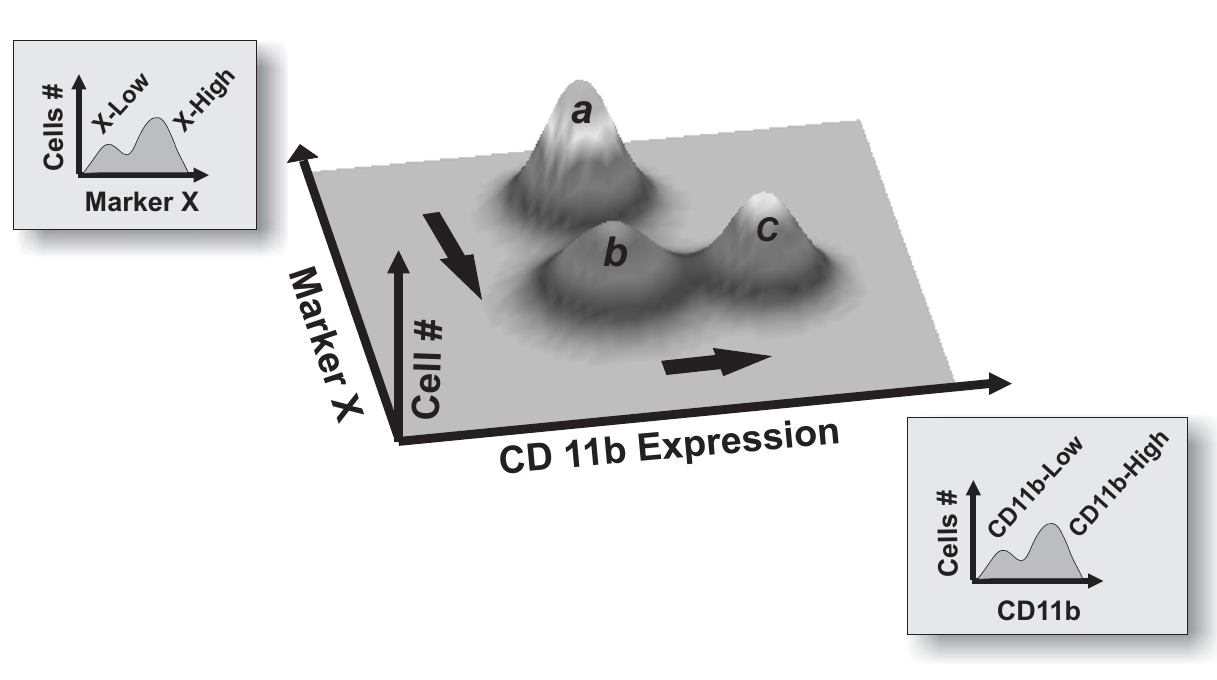
Figure 5 Multistability in multiple state space dimensions . Subpopulations identified as homogeneous with respect to a single marker (i.e., CD11b) may be heterogeneous with respect to another, unmeasured marker (e.g., Marker X). The arrows show a hypothetical path of differentiation whereby cells first change marker X expression ( a to b ) and then CD11b expression ( b to c ). An isolated CD11b Low subpopulation thus may contain two (meta)stable states with respect to marker X (i.e. states a and b